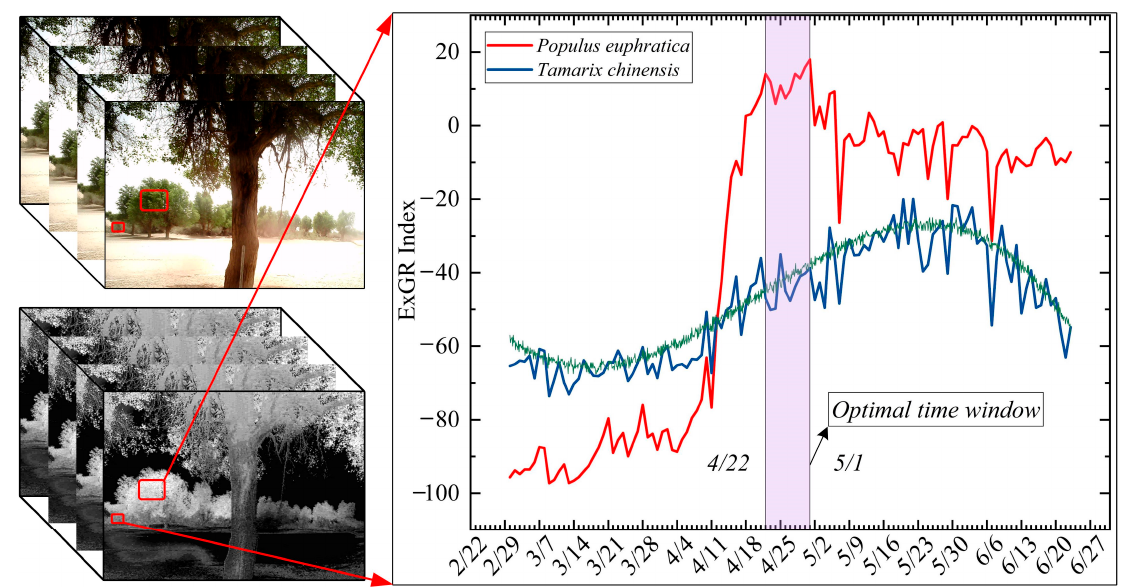
Figure 9. Greenness change curves of Populus euphratica and Tamarix chinensis in spring.